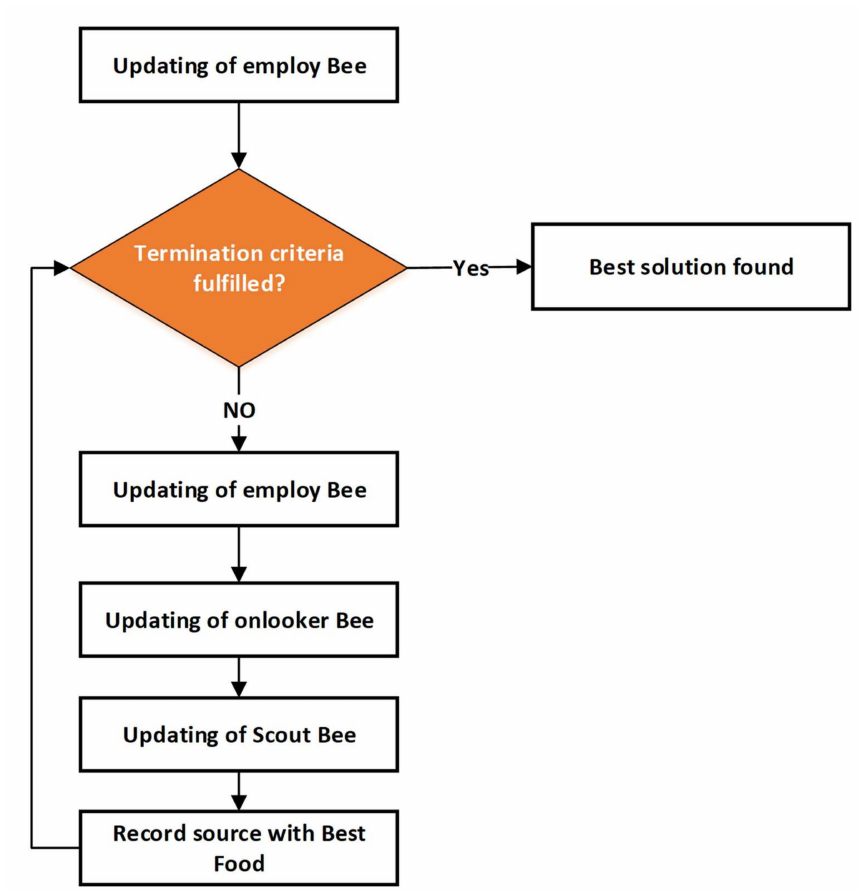
Figure 7. Flowchart of Artificial Bee Colony